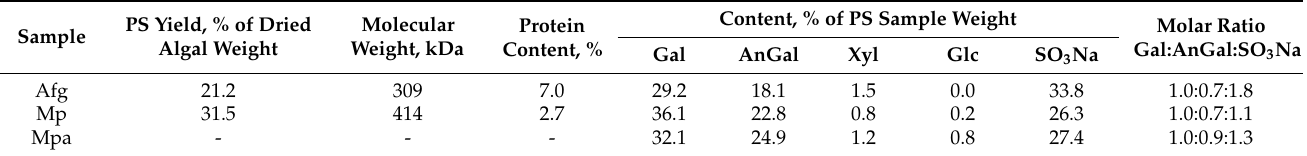
Table 1. Yields and chemical analysis of polysaccharides (PS) from A. flabelliformis and M. pacificus